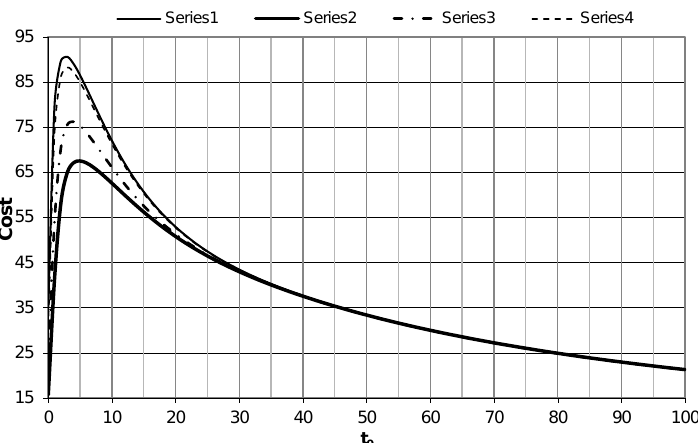
Fig. 4: The cost function based on different parameter values Figure 3. The availability of the system based on different parameter values.